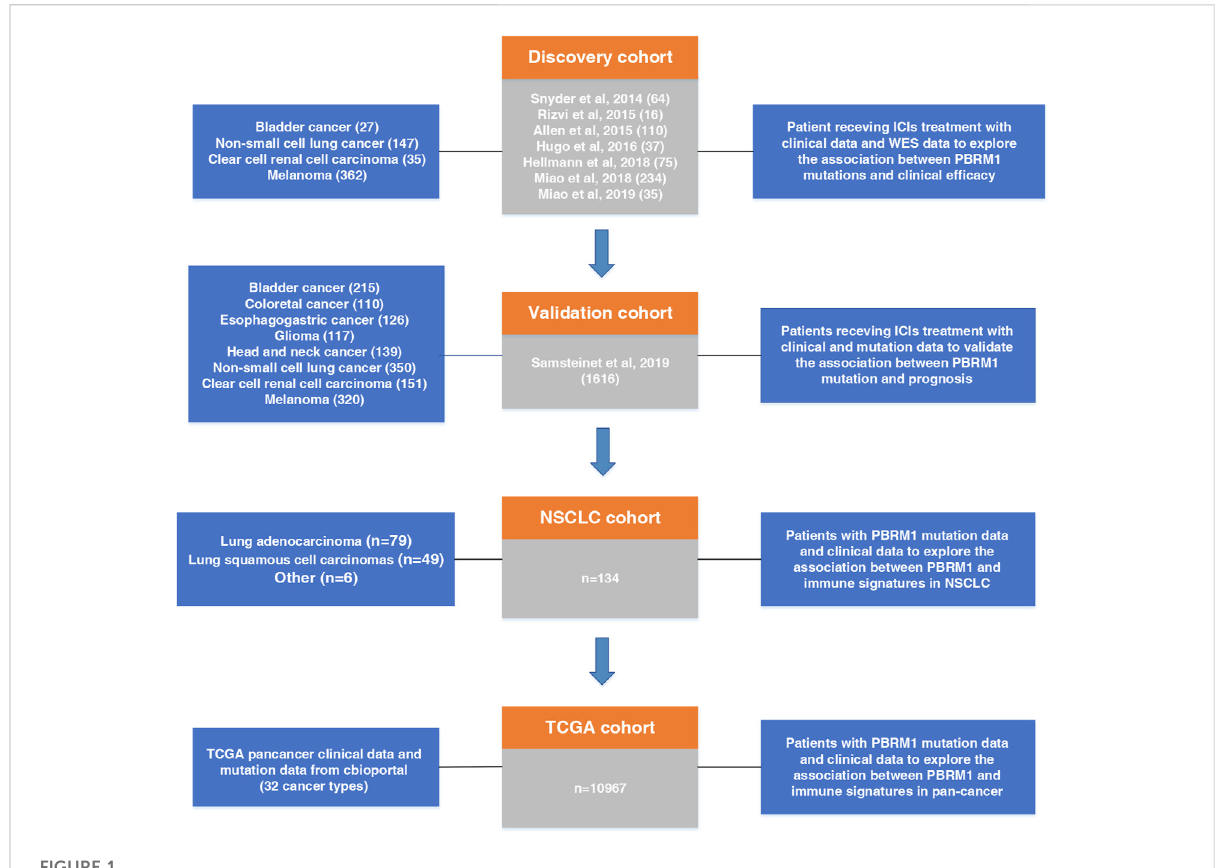
FIGURE 1 Flowchart of the study